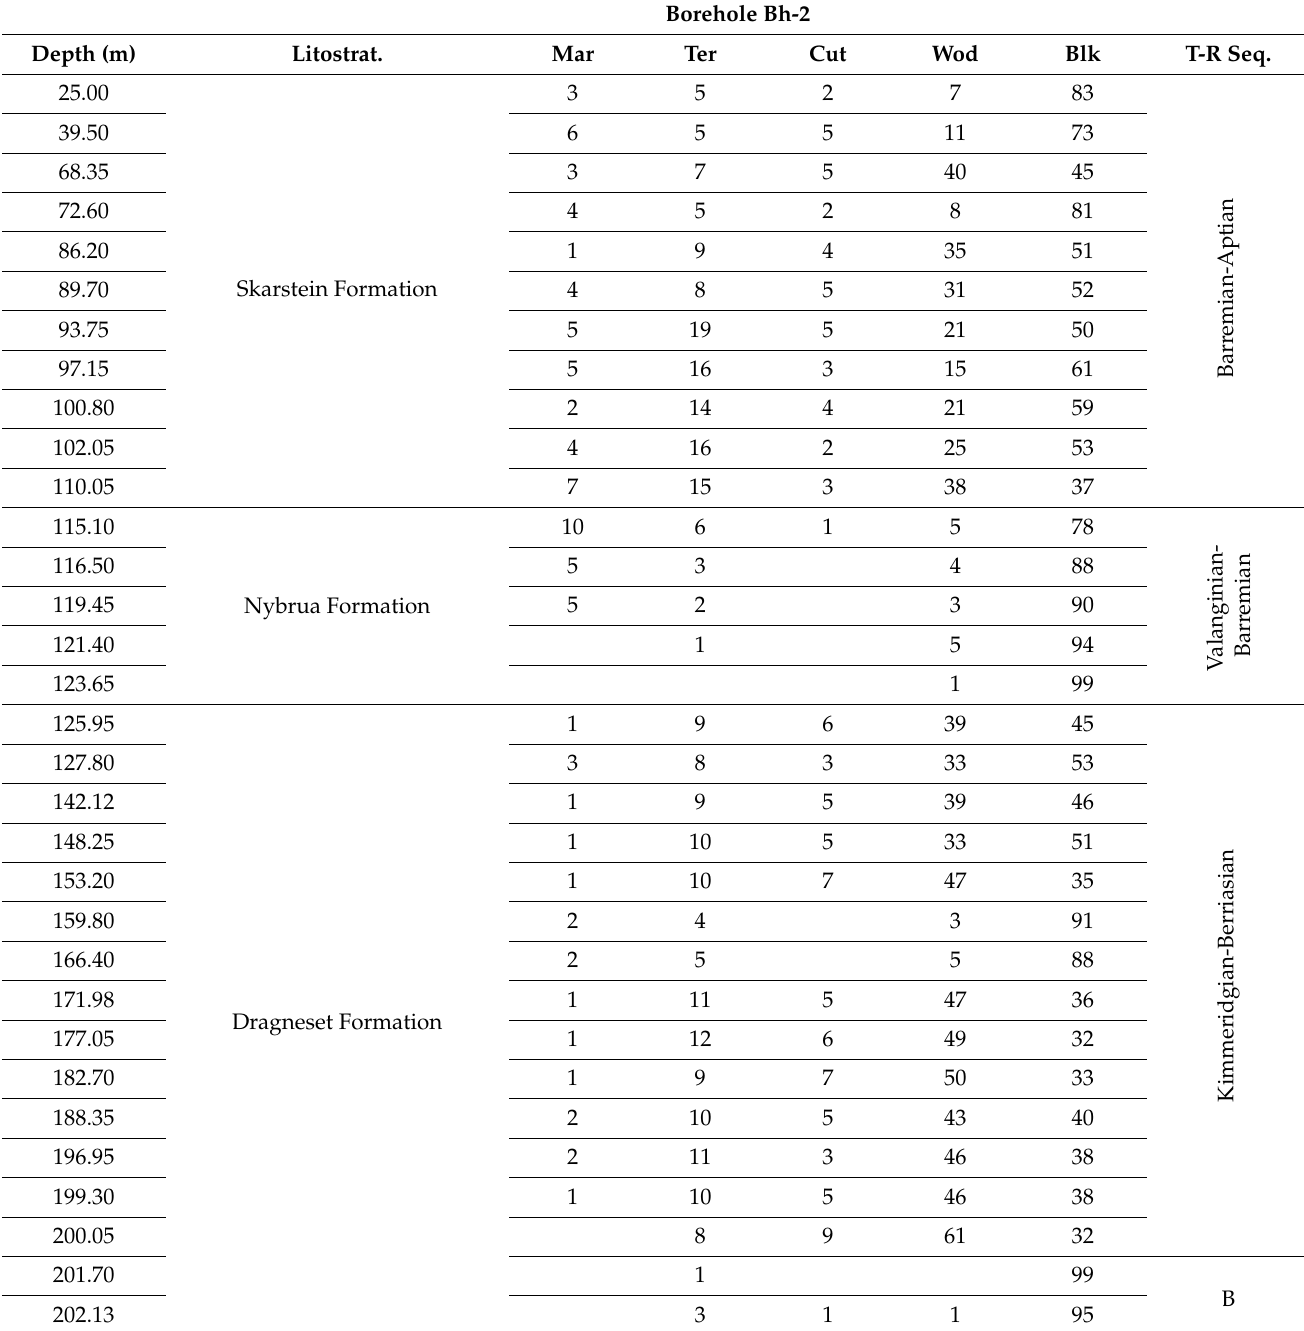
Table 2. Percentages of various groups of particulate organic matter (POM) in Borehole Bh 2. B = weathered basement. Mar = marine palynomorphs (acritarchs, dinoflagellate cysts, prasinophycean algae); Ter = terrestrial palynomorphs (pollen, spores); Cut = cuticule; Wod = Woody fragments; Blk = black, coaly fragments